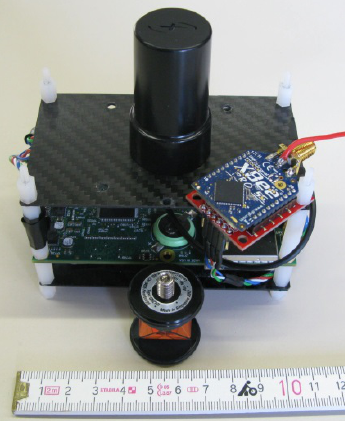
Figure 3. TOPCON dual frequency receiver OEM1 with XBEE radio module and dual frequency antenna Maxtena M1227HCT-A-SMA (optional: 360°miniprism for target tracking with a tachymeter)